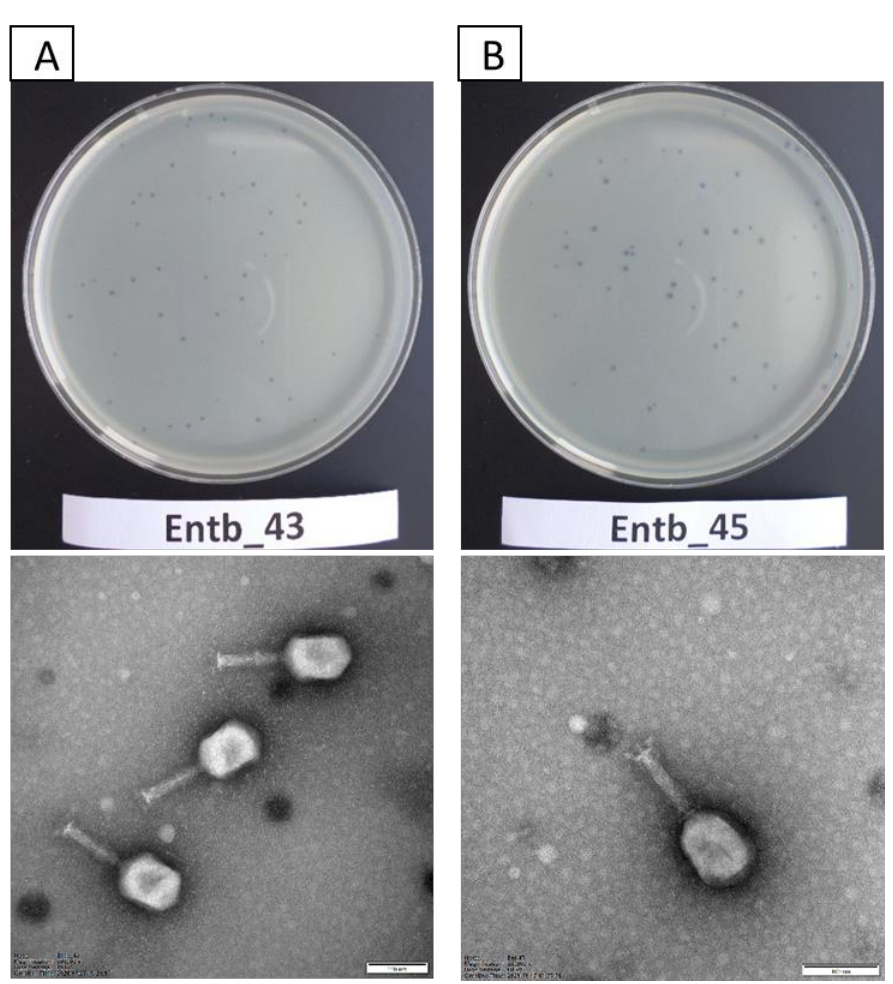
Figure 1. Plaque morphology on agar plates (upper panel) and electron micrographs of phages (lower panel): ( A ) phage Entb_43 and ( B ) phage Entb_45. The photographs of the phages’ plaques were taken using a Samsung ST150F camera. Electronograms of the phages were taken using Kodak/Carestream Electron Microscope, at a magnification of ( A ) 200,000× or ( B ) 250,000×; bar in each micrograph indicates 100 nm. Table 4. Dimensions of bacteriophages. Average measurements of ten virions are shown.